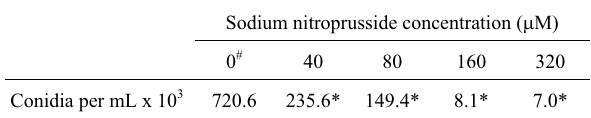
Table 2 - Influence of 40 to 320 (cid:1) M of sodium nitroprusside on conidia- tion in Aspergillus nidulans strain A757. Sodium nitroprusside concentration ( (cid:1) M)